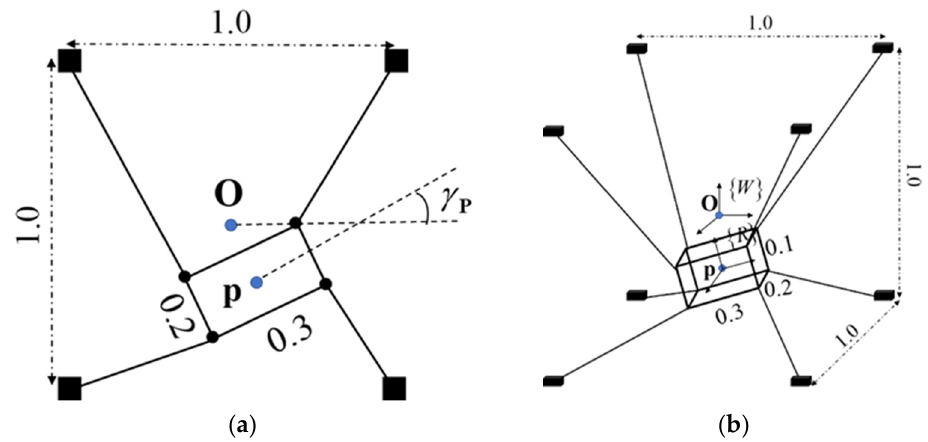
Figure 1. Two configurations CDPM: ( a ) 1-redundantly actuated planar CDPM; ( b ) 2-redundantly actuated spatial CDPM.